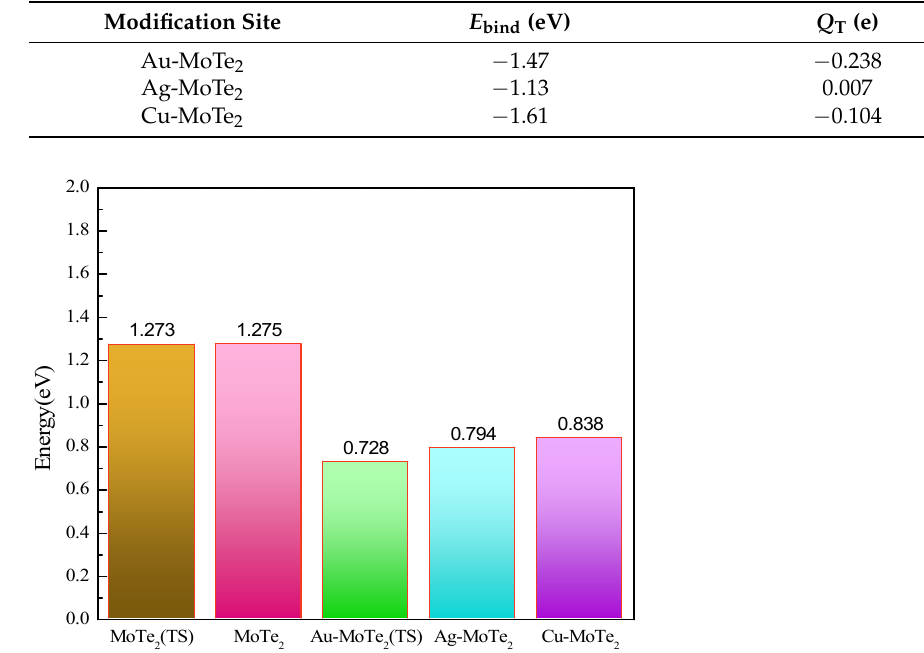
Figure 3. The bandgaps of the pristine MoTe 2 monolayer and TM-MoTe 2 monolayer.